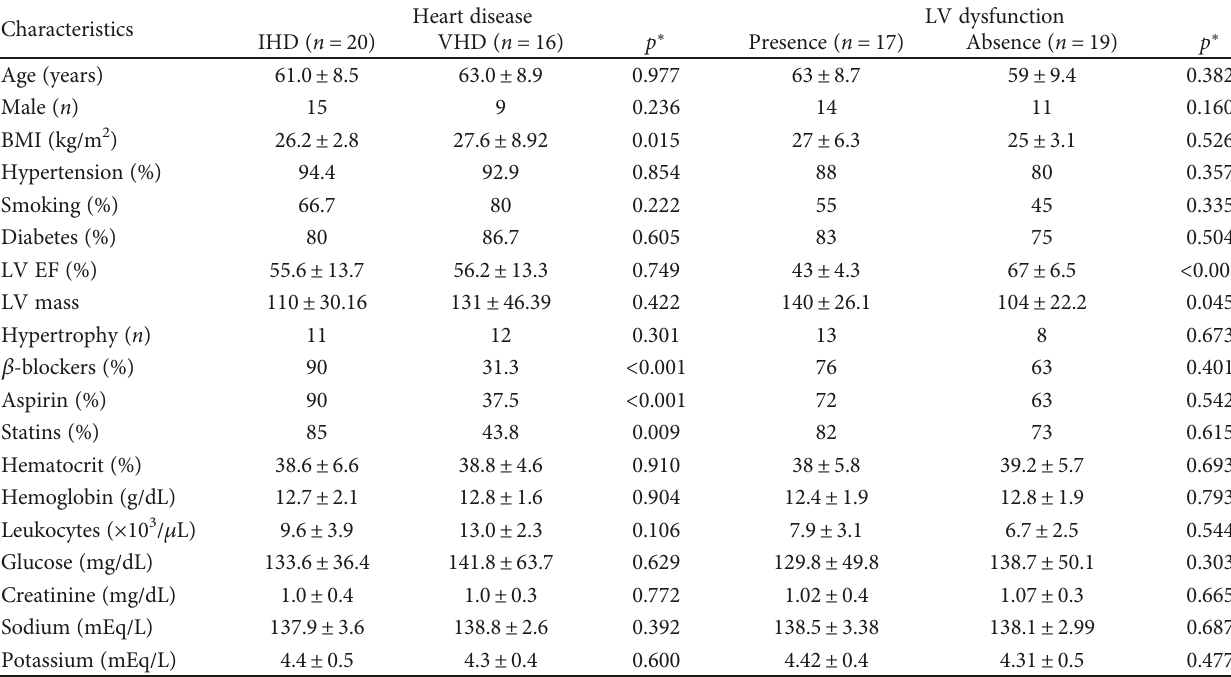
Table 1: Baseline characteristics of the study population.